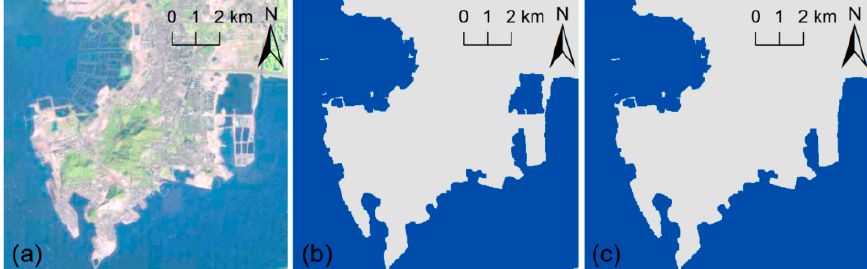
Figure 2. An example of generating a land-ocean map using Landsat data. ( a ) The Landsat image of Shekou Peninsula in Shenzhen in 2003; ( b ) the land-ocean map before automatic coastline extraction processing; and ( c ) the land-ocean map after automatic coastline extraction processing.